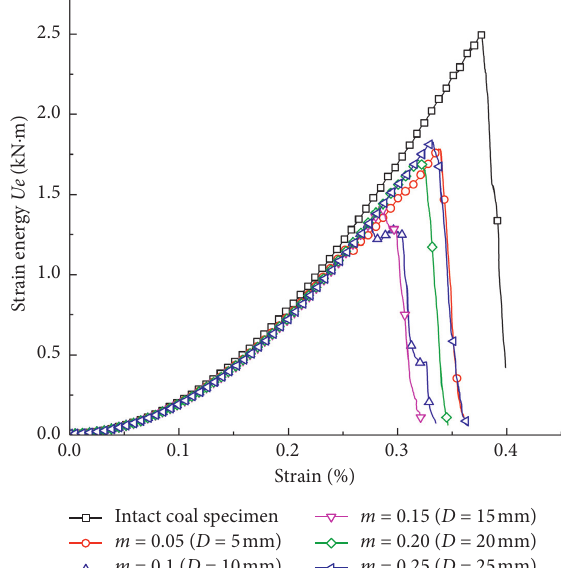
Figure 9: Curve of strain energy U